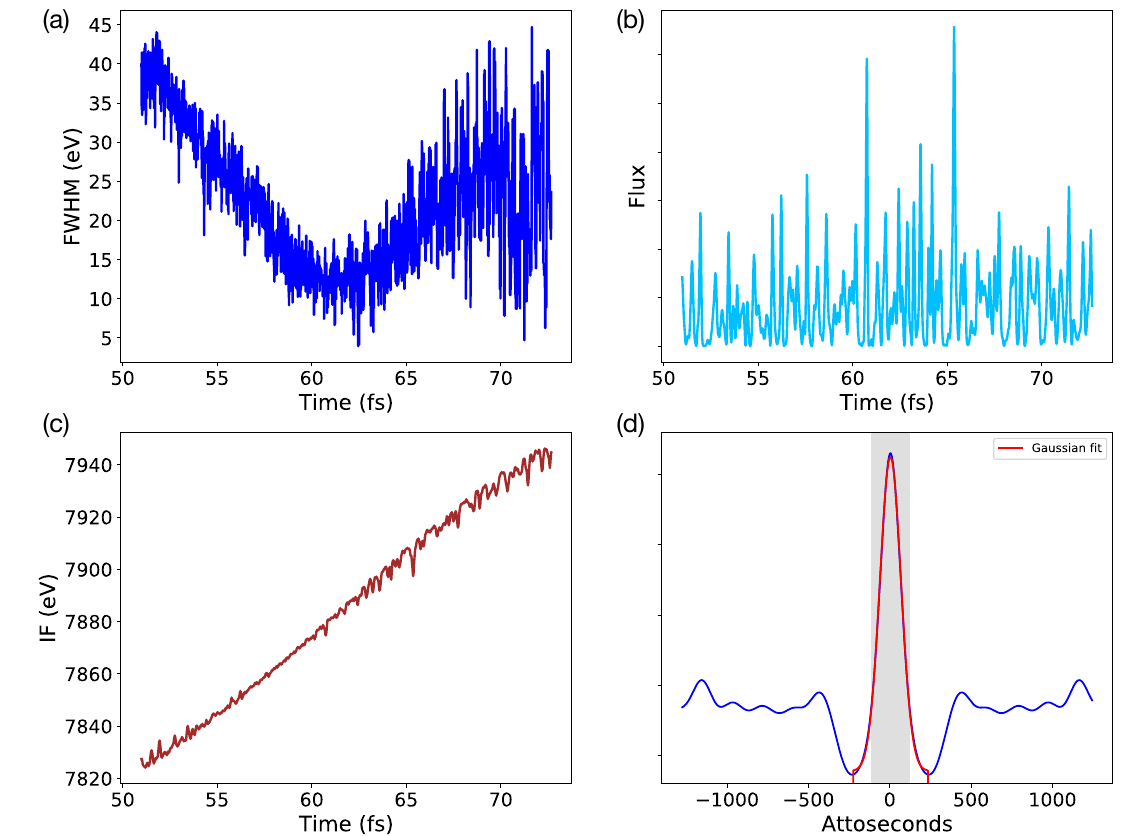
Figure 3. Central slicing of the pulse with 4% chirp. ( a – c ) respectively plot the FWHM in , flux, and IF values when the pulse is sliced at these central 20-fs. The flux is constant across this central slice and the energy chirp is reduced to ≈ 1.5%. The FWHM in fluctuates between 40–10 eV. ( d ) Short-range “single-shot” autocorrelation of the central 20-fs of the pulse: the SASE spike width is on the order of 200